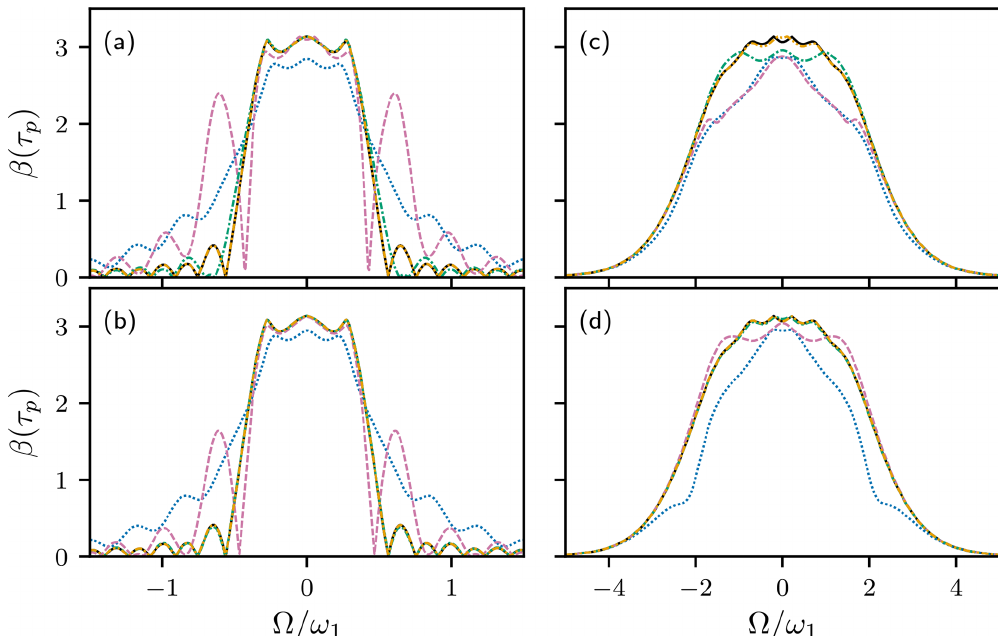
Figure 4. HAM approximations for (a, b) REBURP and (c, d) WURST-20 inversion pulses. Numerical calculation of Euler angle β ( τ p ) using Eqs. (1)–(3) (black line). (a, b) First-order (blue dotted line), second-order (reddish-purple dashed line), third-order (green dash-dotted line), and fifth-order (orange dash–dot–dotted line) HAM results, using method 1. (c, d) Fifth-order (blue dotted line), seventh-order (reddish- purple dashed line), ninth-order (green dash-dotted line), and 11th-order (orange dash–dot–dotted line) HAM results, using method 1. Results are shown for (a, c) c 0 = − 1 and (b, d) c 0 = − 0 . 925. The numerical calculation and (a, b) fifth-order and (c, d) 11th-order HAM curves are nearly